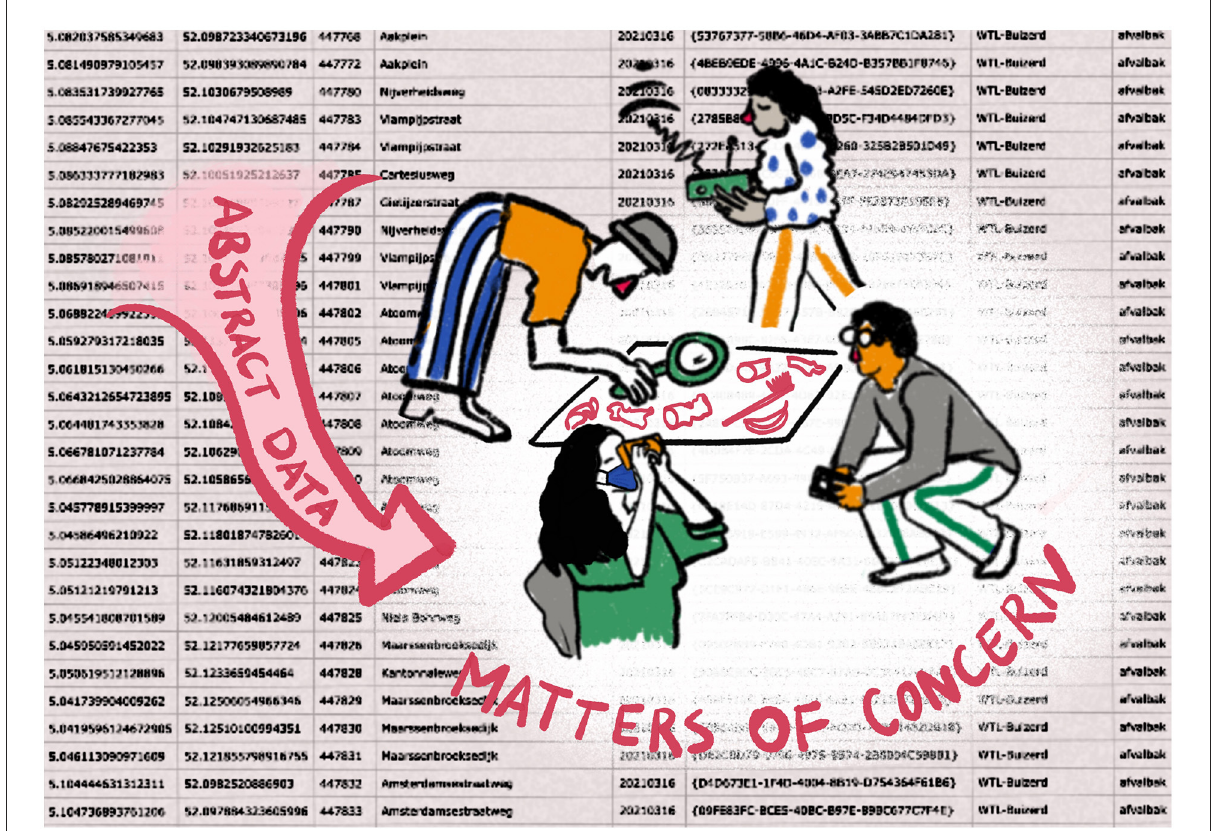
FIGURE8 Translation as meaning-making: from abstract data to matters of